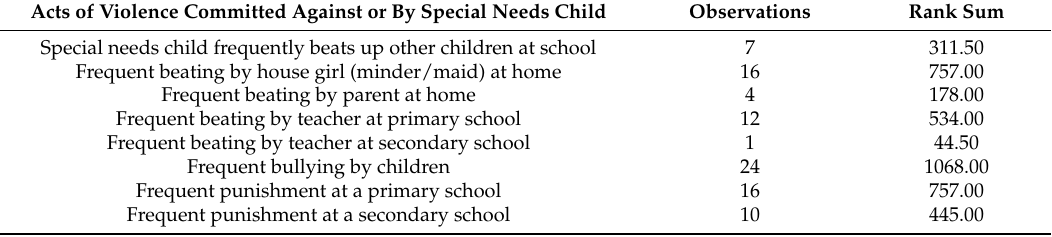
Table 1. Acts of violence committed against or by special needs